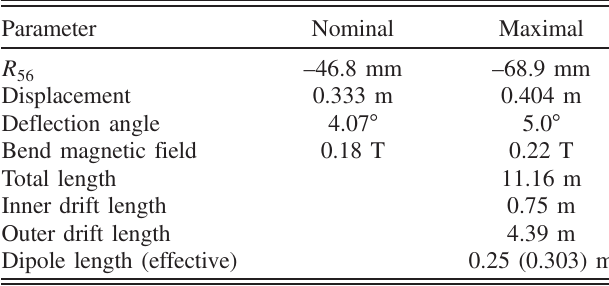
TABLE XI. Main bunch compressor